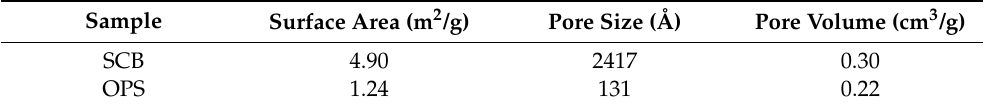
Table 2. BET measurements of SCB and OPS.